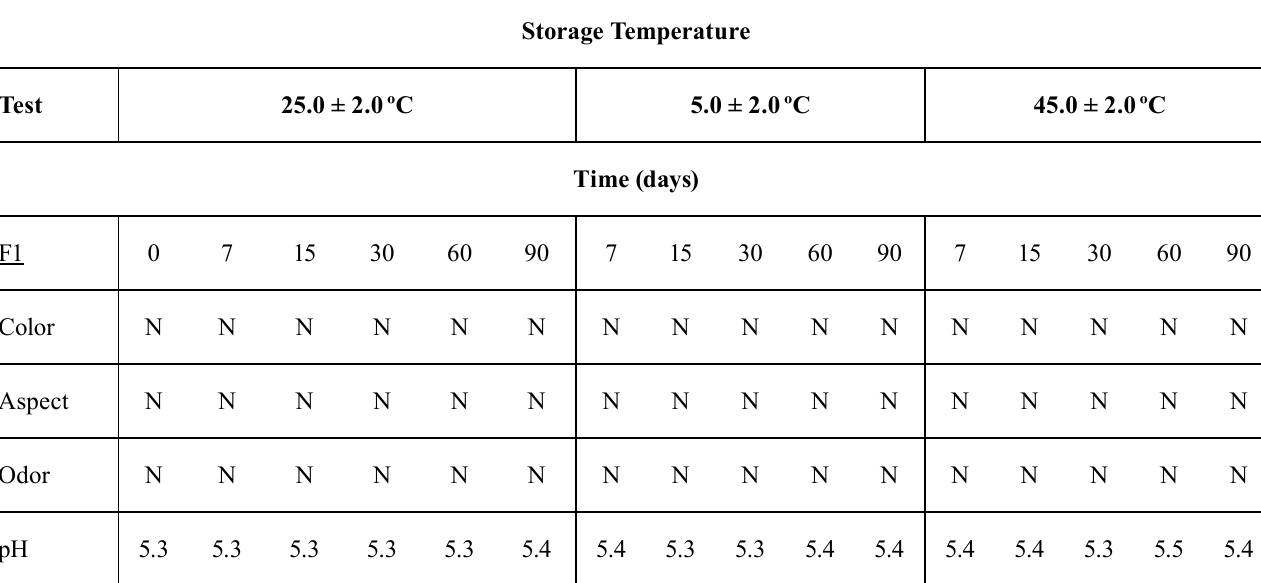
TABLE III – Organoleptic characteristics (aspect, color and odor) and pH value submitted to the Normal Stability Assessment ( NSA ) during the 90